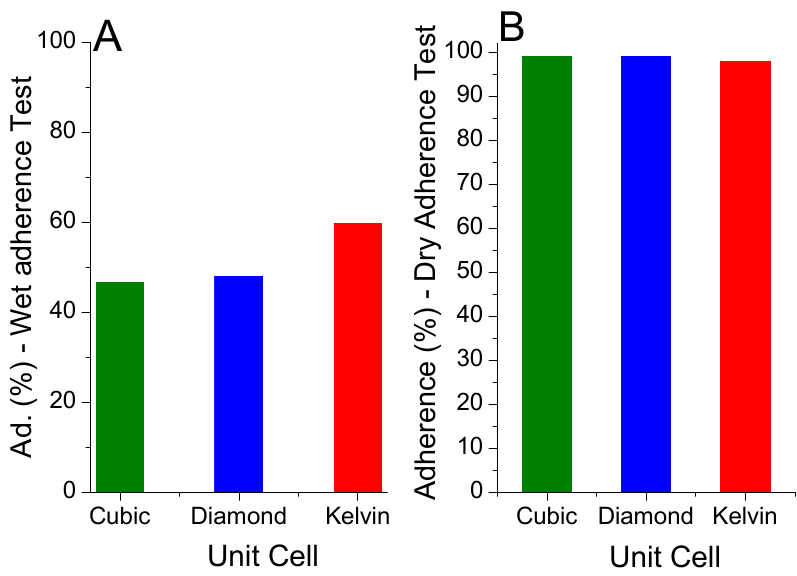
Figure 11. Adhesion tests: ( A ) wet adhesion test; ( B ) dry adhesion test.